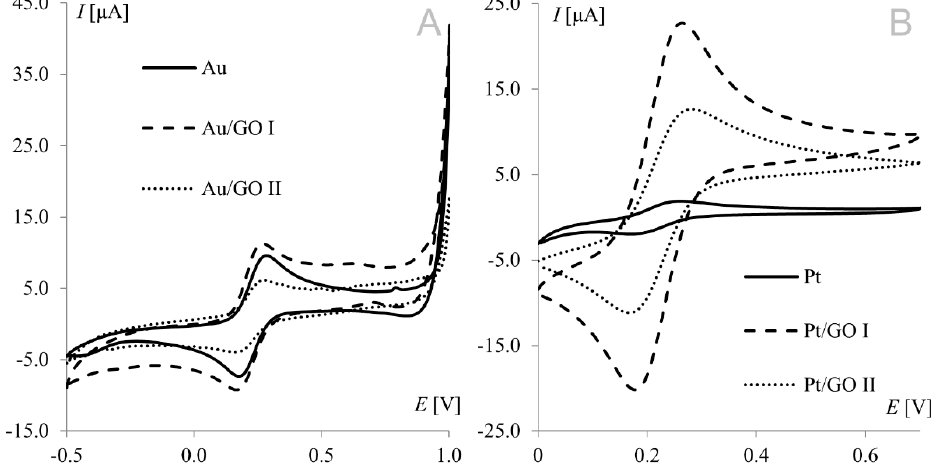
Figure 1. Voltammograms of 1 mM Fe(CN) 63 − / Fe(CN) 64 − recorded from bare, graphene oxide I-, and graphene oxide II-modified working electrodes (( A ) gold electrode, ( B ) platinum electrode); scan rate, 50 mV s − 1 ; supporting electrolyte, 1 M KCl.